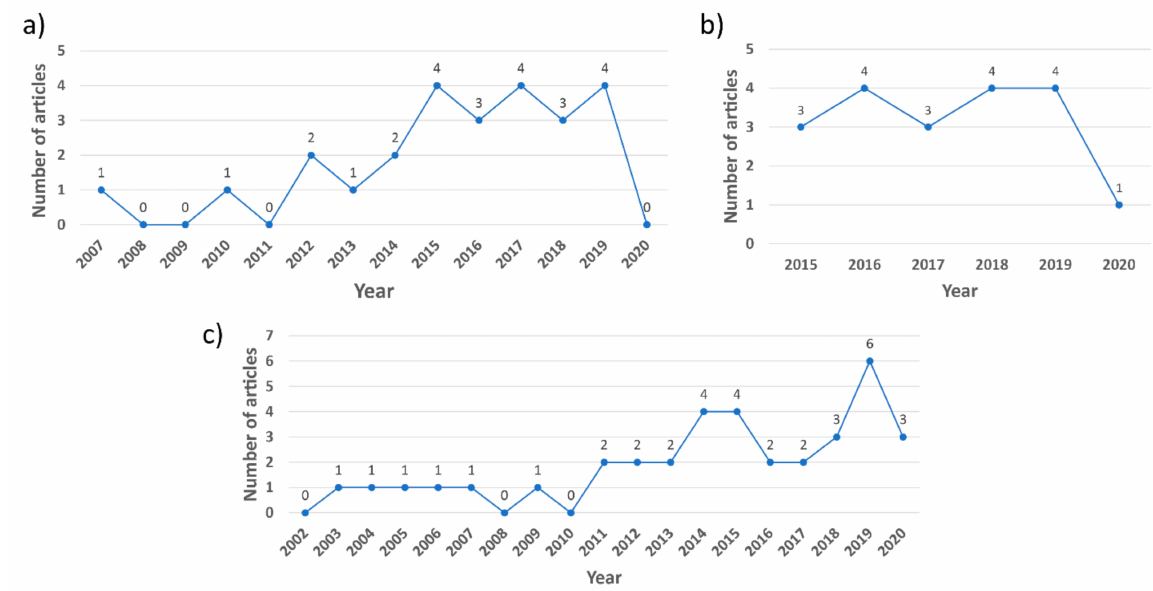
Figure 3. Temporal trends of eye tracking research articles in the aviation, maritime, and construction industries published between 2000 and 2020 (N = 80).